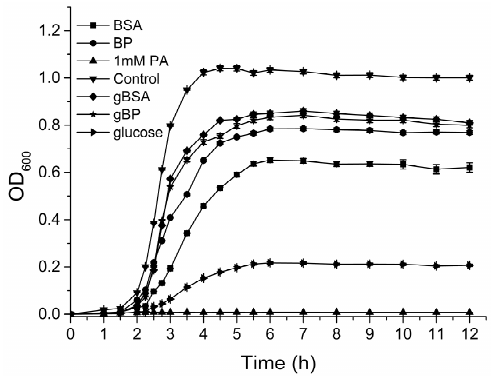
Figure 3. Effects of pyrogallic acid (PA) on the growth curve of SA in different environments.